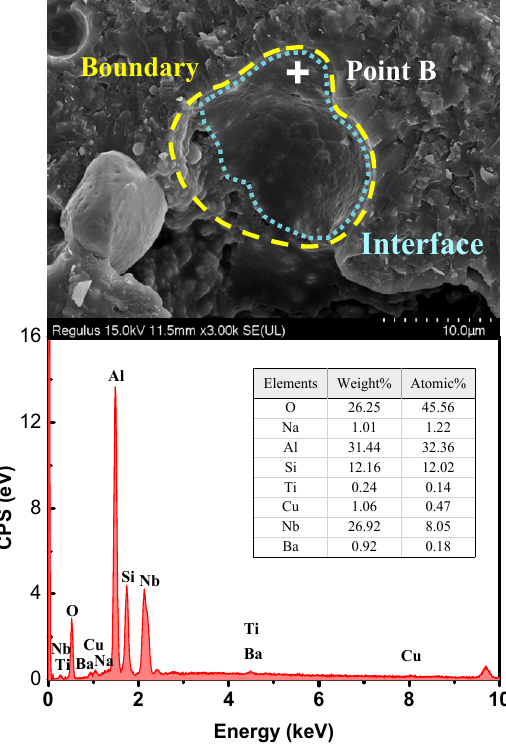
Figure 10. Microstructure and EDS result of the crater left by the TC particle.